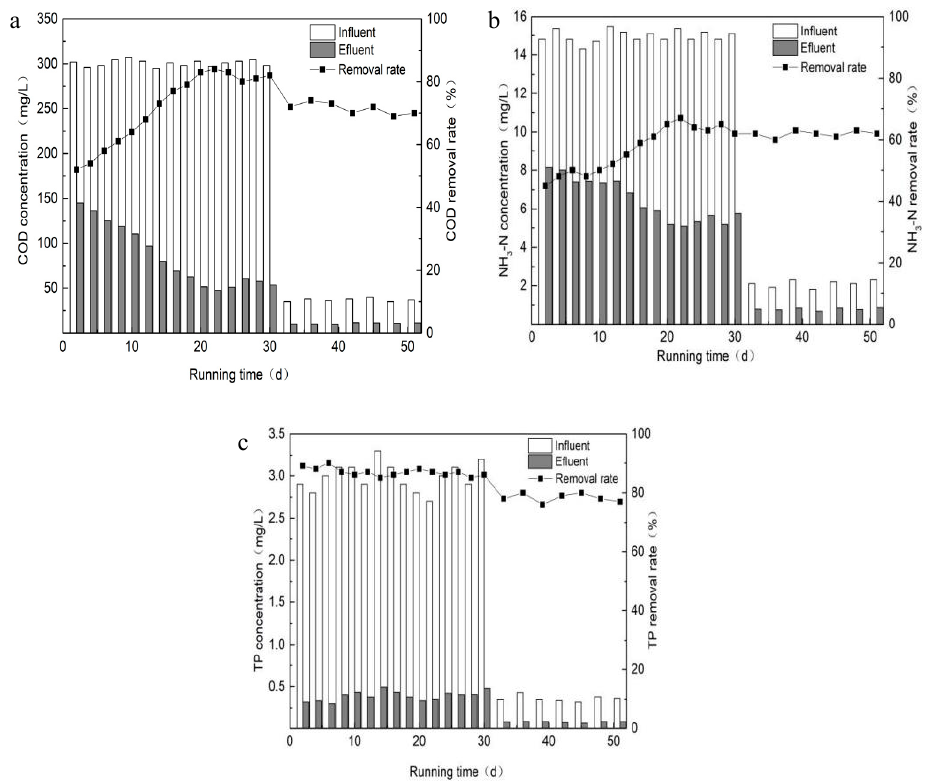
Figure 4. Chart of chemical oxygen demand (COD) ( a ), ammonia nitrogen (NH 3 -N) ( b ), and total phosphorus (TP) ( c ) removal during the start-up stage.